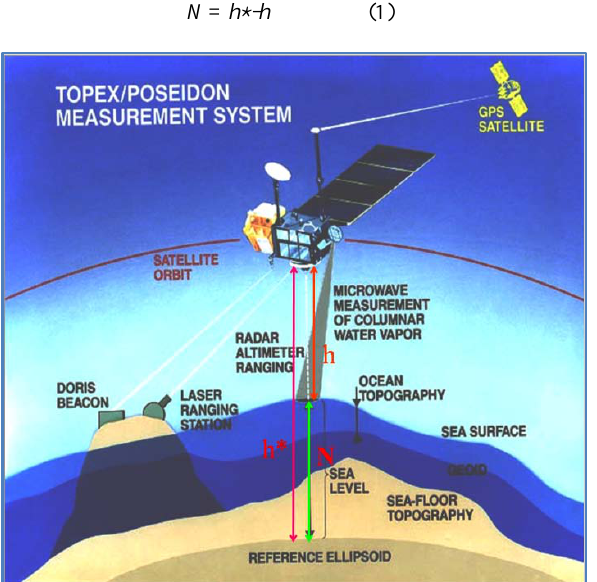
Figure 1. Measurement of Ocean Surface Height by Topex/Poseidon System